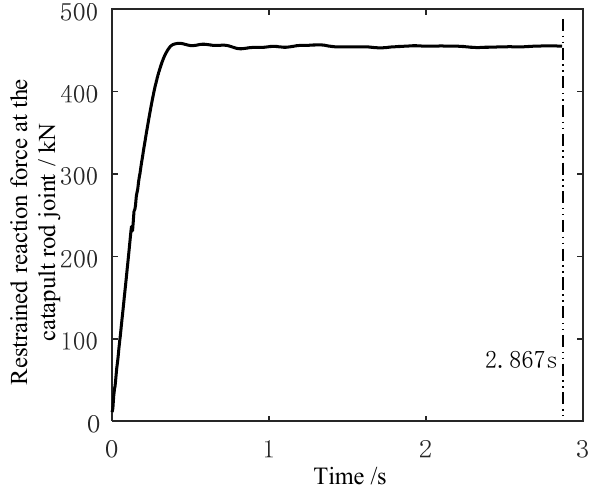
Figure 9. Time versus restrained reaction force at the catapult rod joint.